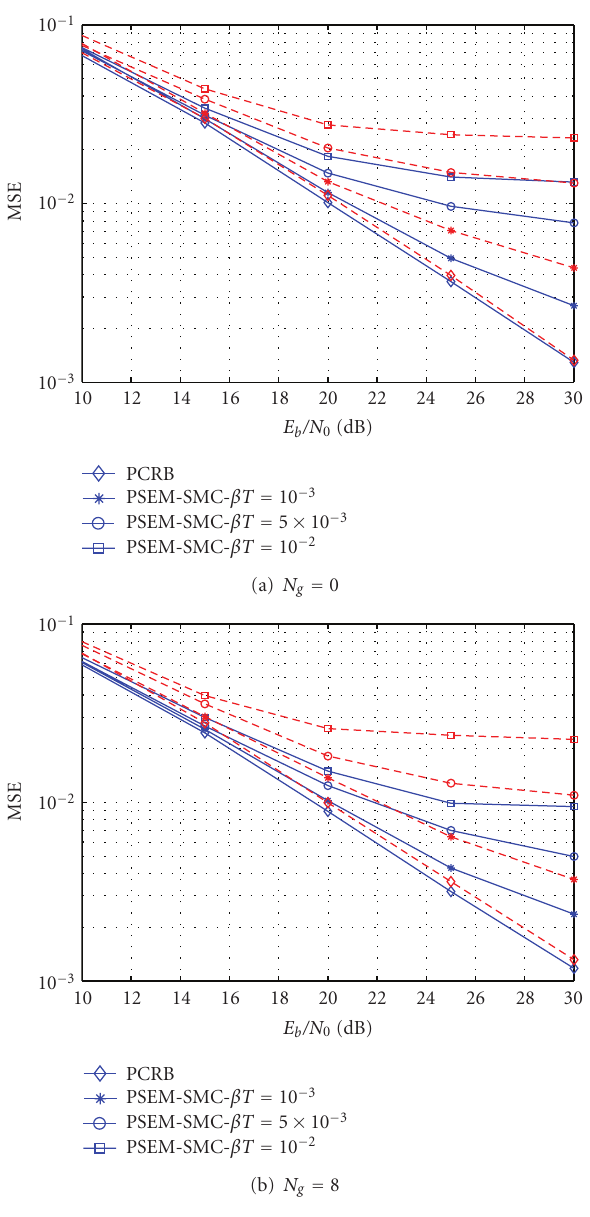
Figure 2: MSE of the multicarrier signal estimate using the proposed AR model (solid lines) and without the AR model (dashed lines) versus E b /N 0 for di ff erent PHN rates βT ( P = 4, (cid:2) = 0 .